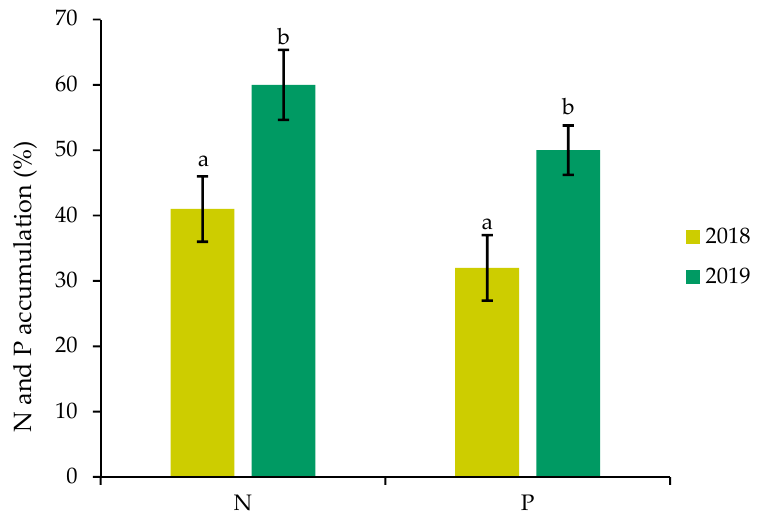
Figure 5. Total N and P accumulation by willow for two years once exposed to WW irrigation in the field (Mean ± SE). N and P accumulation (%) were analyzed using ANCOVA for years. Different small letters represent the significant difference between years at p < 0.05 using Tukey’s HSD test.